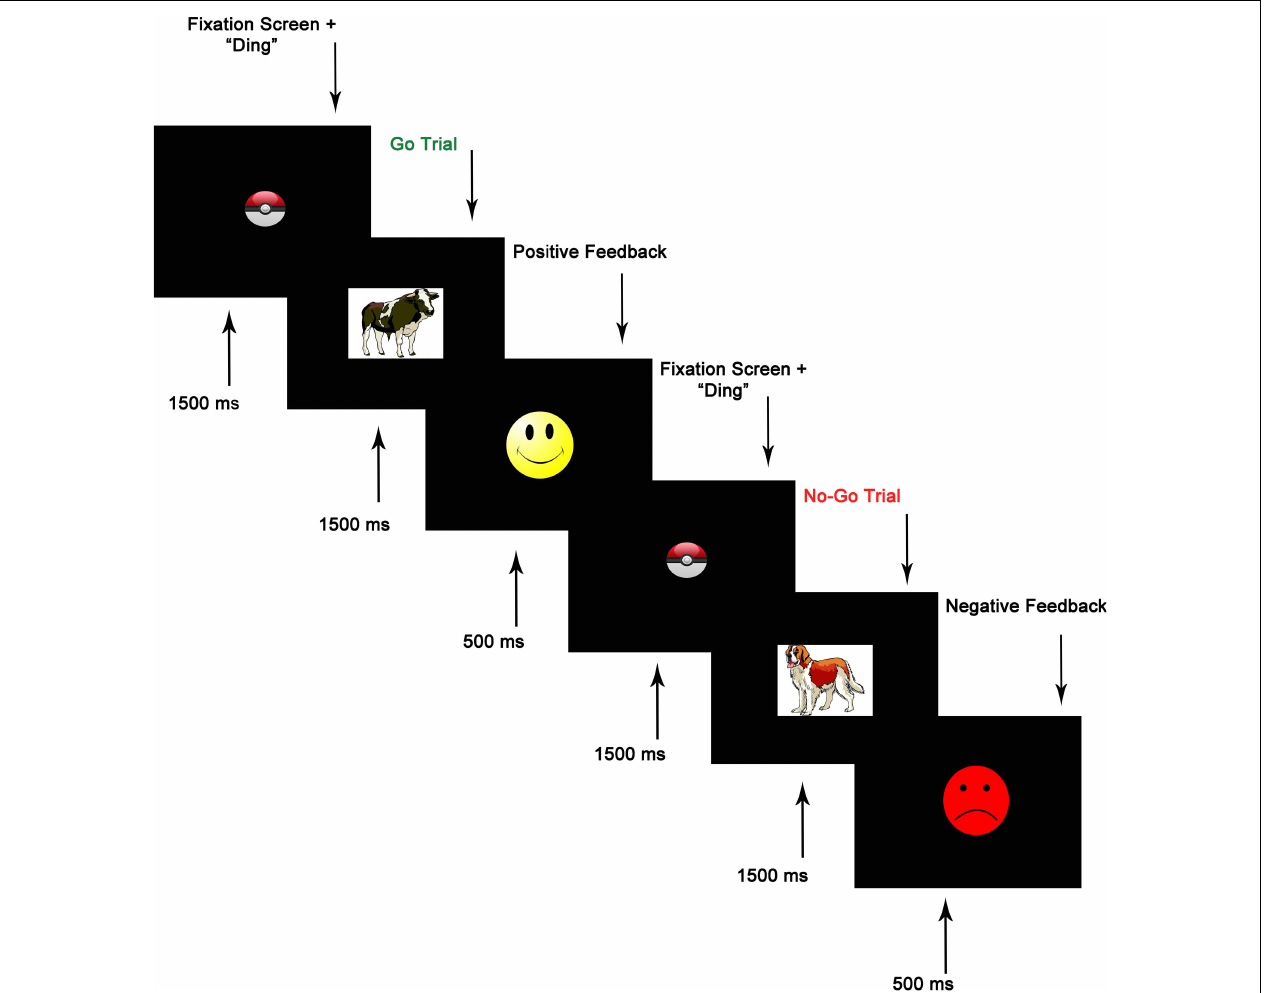
FIGURE 1 | Go/no-go task trial